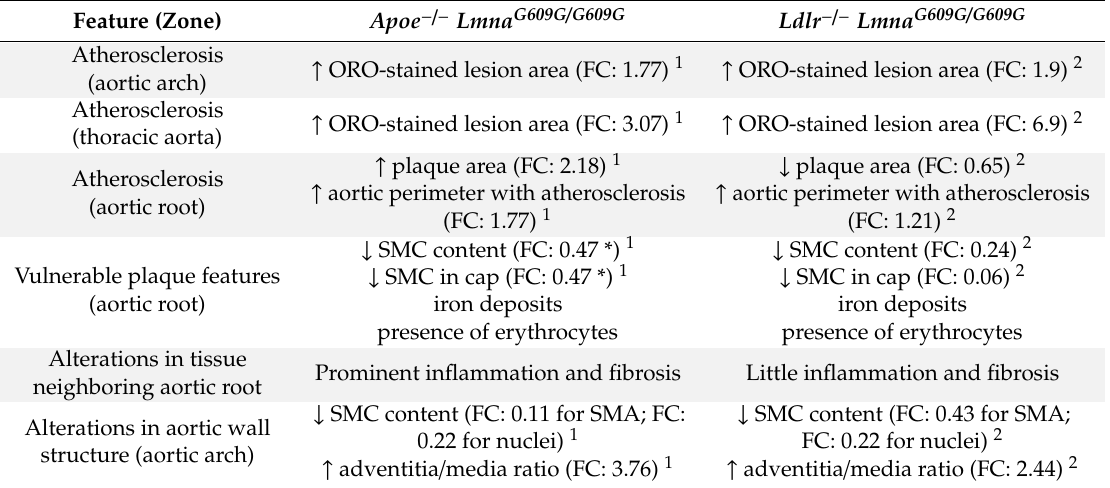
Table A1. Comparison of vascular phenotype between fat-fed male Apoe − / − Lmna G609G / G609G